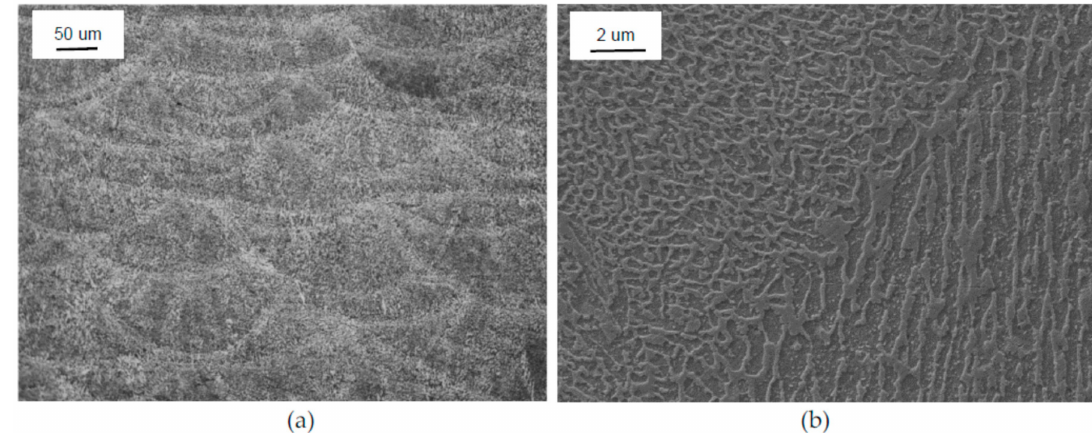
Figure 2. Microstructure of the AlSi10Mg alloy produced by SLM on a hot platform. ( a ) Low magnification optical microscope view (section plan parallel to building direction) of the solidified melt pools left by laser tracks; ( b ) SEM image of the cellular